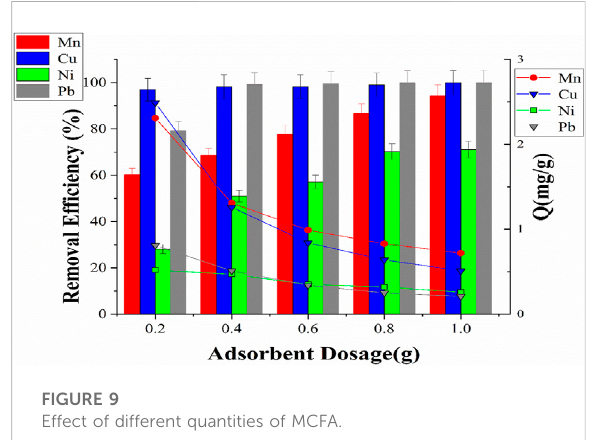
FIGURE 9 Effect of different quantities of